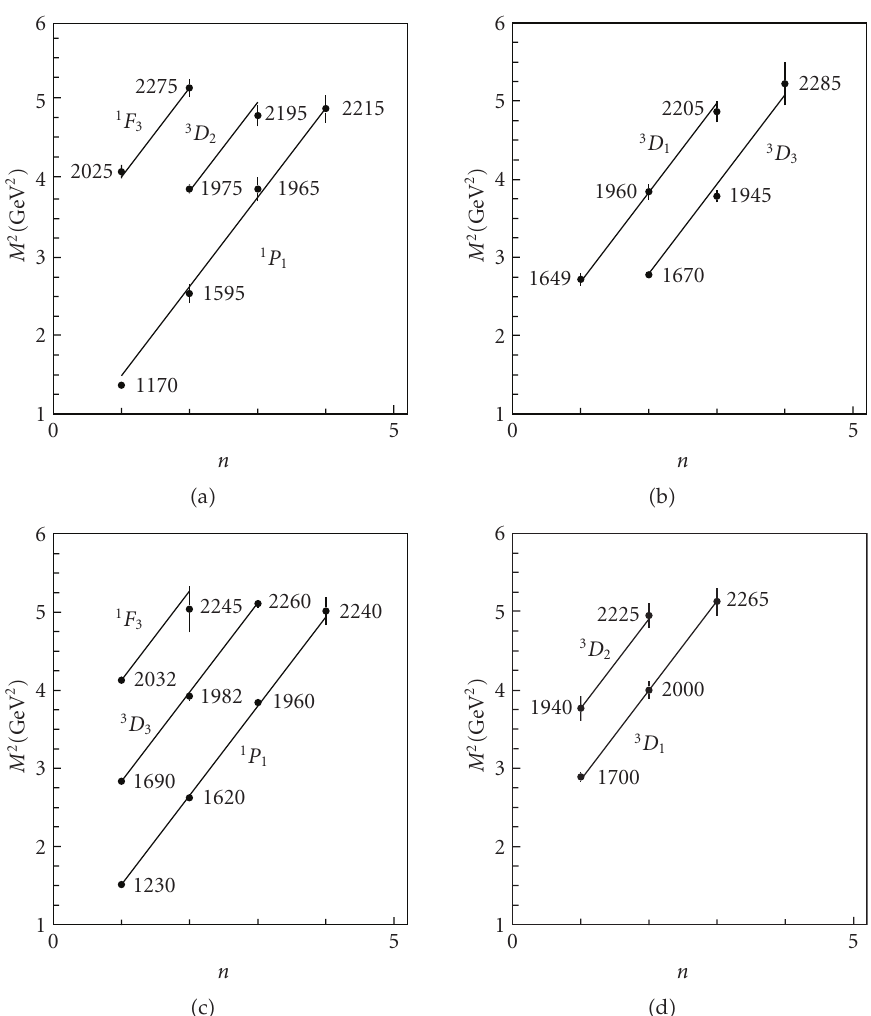
Figure 3: Trajectories of C (cid:12) − 1 states with (cid:2) a (cid:3) and (cid:2) b (cid:3) I (cid:12) 0, (cid:2) c (cid:3) and (cid:2) d (cid:3) I (cid:12) 1. In (cid:2) b (cid:3) , the 3 D 3 trajectory is moved one place right for clarity; in (cid:2) d (cid:3) , 3 D 2 is moved one place left (cid:7) 16–18 (cid:8)